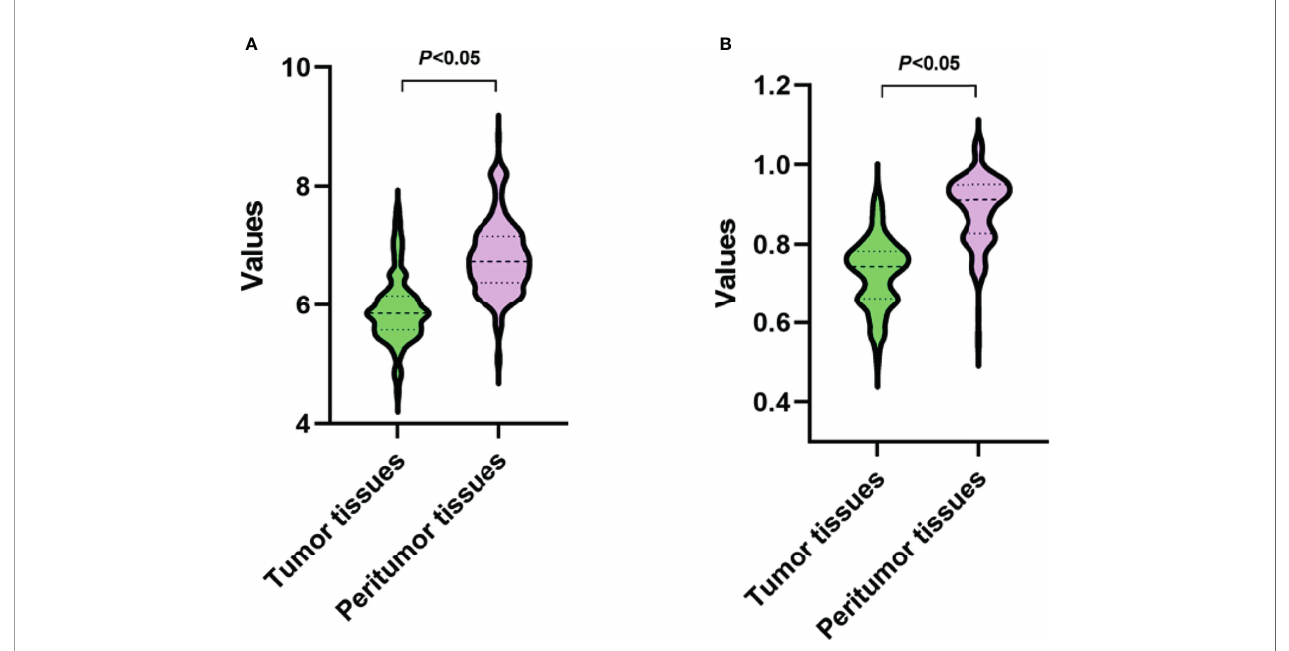
FIGURE 5 | Values of two robust radiomic features in tumor and peritumor tissues. (A, B) present the features of GLDM-dependence entropy and GLRLM short run emphasis, respectively.